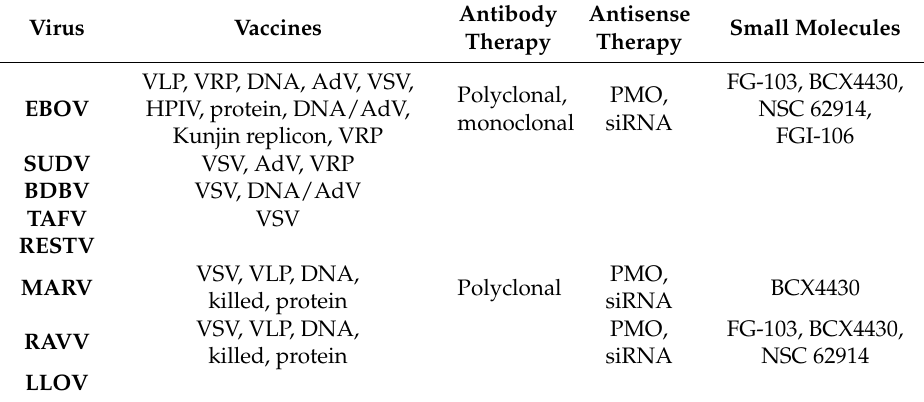
Antibody Antisense Small Molecules Therapy Therapy FG-103, BCX4430, Polyclonal, PMO, NSC 62914, monoclonal siRNA FGI-106 PMO, BCX4430 Polyclonal siRNA PMO, FG-103, BCX4430, siRNA NSC 62914